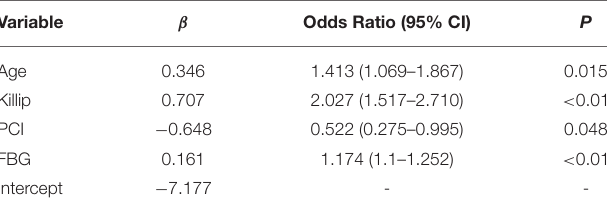
TABLE 3 | Logistic regression model for predicting in-hospital MACCE in ACS.